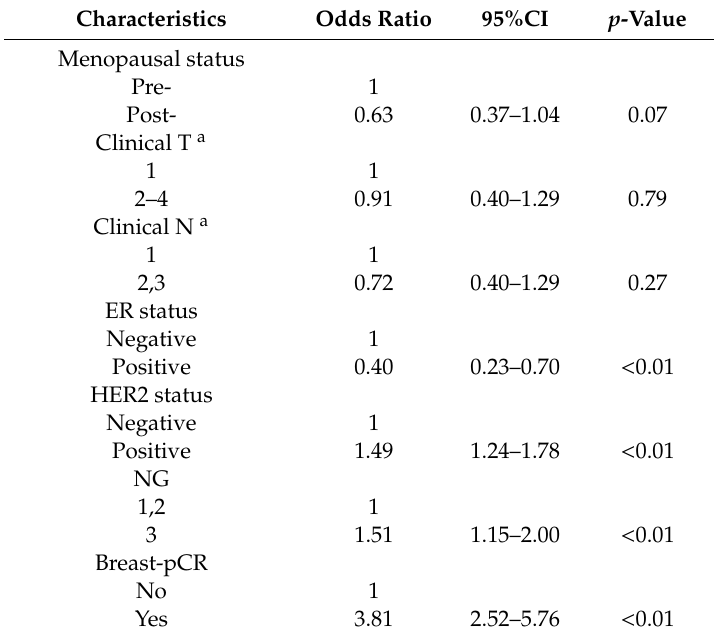
Table 3. Factors associated with axillary pCR using multivariate logistic regression